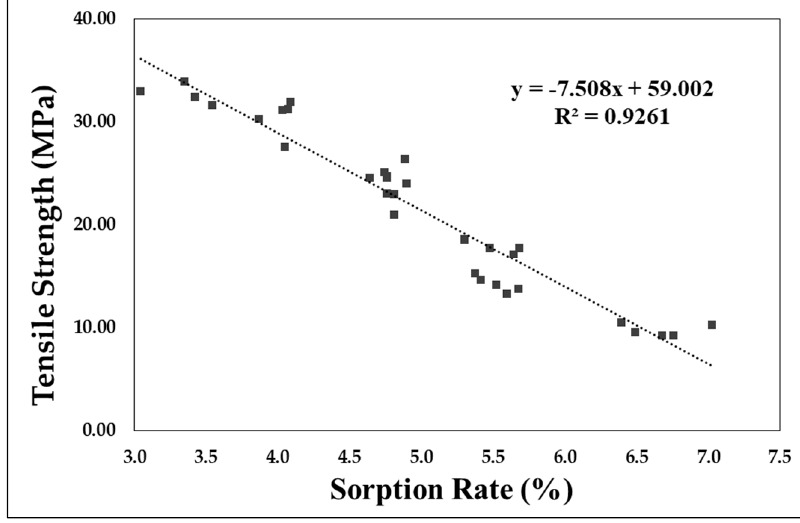
Polymers 2019 , 11 , x FOR PEER REVIEW Figure 13. Tensile strength of APET based on CO 2 sorption rate. Figure 13. Tensile strength of APET based on CO 2 sorption rate. Figure 13. Tensile strength of APET based on CO 2 sorption rate.